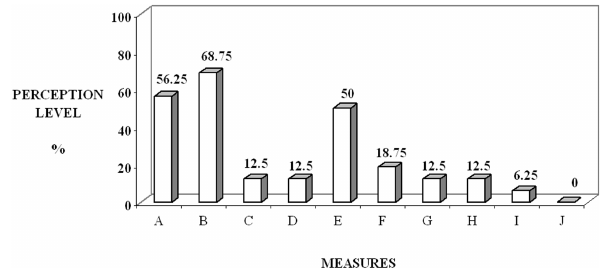
Fig. 9. Preferences for different management measures. Affected temporal residents.